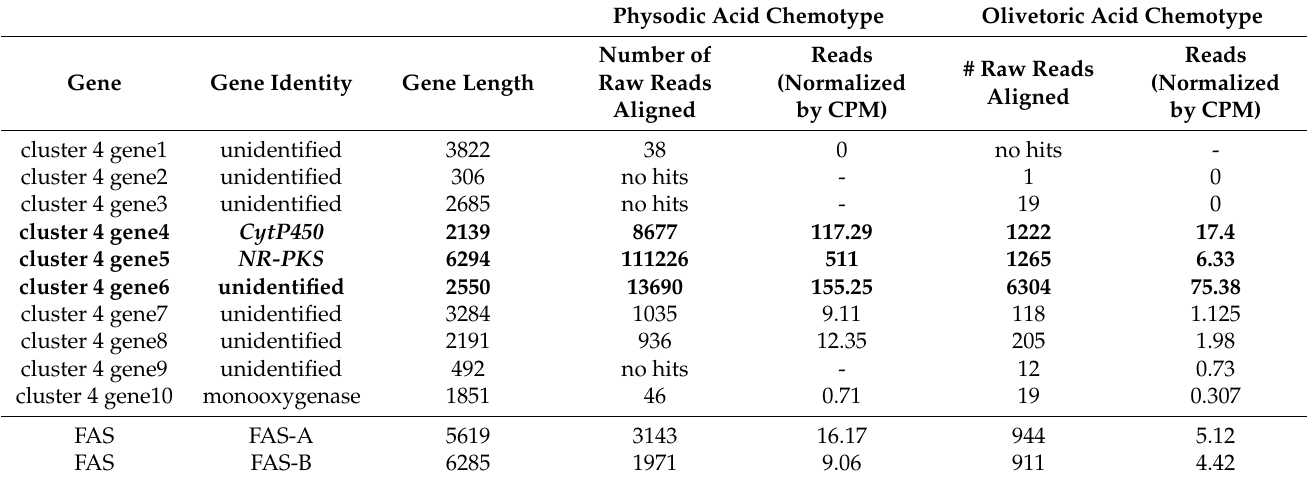
Table 4. Read count of the genes of cluster 4 and P. furfuracea homologs of HexA and HexB of the physodic acid and olivetoric acid